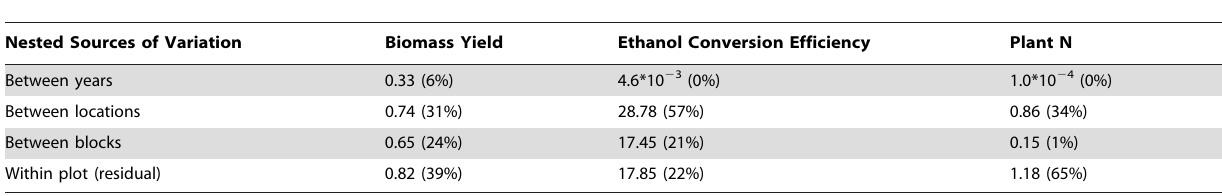
Table 3. The contribution of variation from nested random effects for measures of bioenergy quantity and quality.